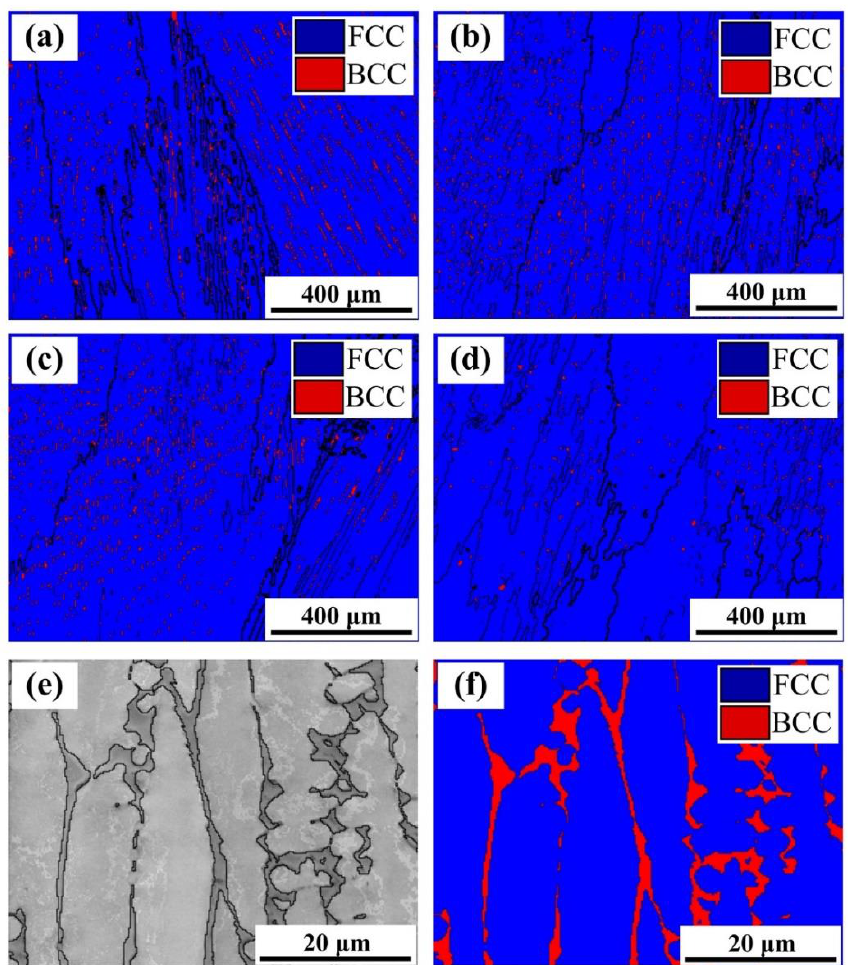
Figure 7. EBSD phase distribution diagrams of LMD-Al 0.5 FeCoCrNi walls under different heat dissipation rates: ( a ) T-0; ( b ) T-20; ( c ) T-40; ( d ) T-60; ( e ) The enlarged band contrast map; ( f ) Dendrite and interdendritic area.